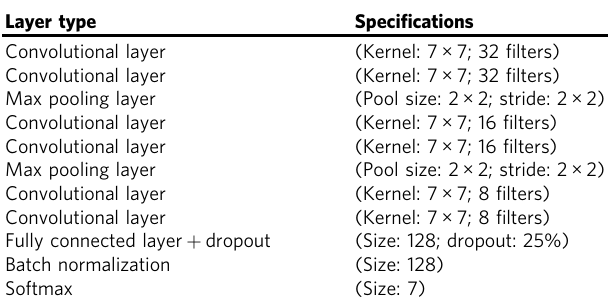
Table 2 Architecture of the convolutional neural network used in this